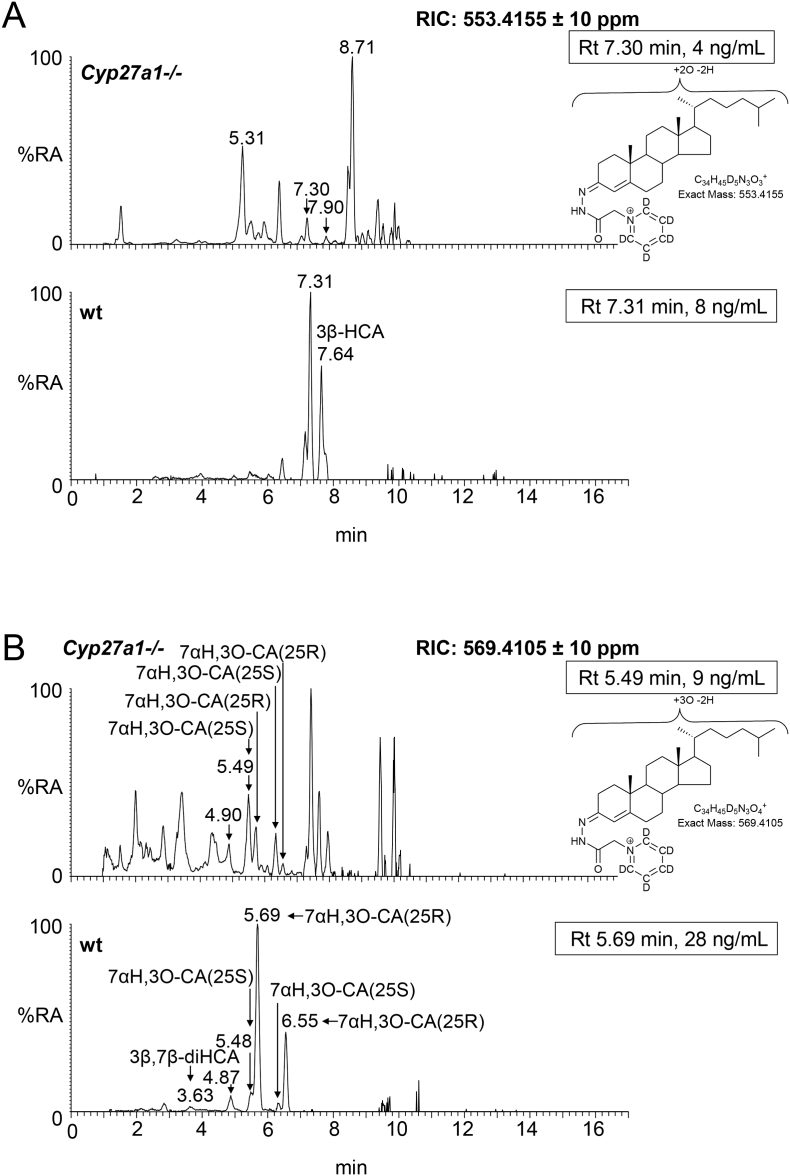
Cholestenoic acids in Cyp27a1−/− and Cyp27a1+/+ (wt) mouse plasma. Each chromatogram is normalised to the most intense peak at 100% RA. Magnification factors are as indicated. The concentration of the indicated analyte (by Rt) is given in the right-hand corner of each chromatogram. Chromatograms from the oxysterol fractions treated with cholesterol oxidase (combination of sterols with a native 3-oxo group and those oxidised by cholesterol oxidase to contain a 3-oxo group) are shown in (A)–(B). The insets show structures of generic GP derivatives. Many cholestenoic acids elute as twin peaks corresponding to syn and anti conformers. (A) 3β-Hydroxychest-5-enoic and 3-oxocholest-4-enoic acids, and dihydroxycholestenones and hydroxycholestenediones. (B) Dihydroxycholestenoic and hydroxyoxocholestenoic acids. (C) Dihydroxyoxocholestenoic acids. Abbreviations: 3β-HCA, 3β-hydroxycholest-5-en-(25R)26-oic; 7αH,3O-CA(25R or S), 7α-hydroxy-3-oxocholest-4-en-(25R or S)26-oic; 3β,7β-diHCA, 3β,7β-dihydroxycholest-5-en-26-oic; and 7α,12α-diH,3O-CA(25R or S), 7α,12α-dihydroxy-3-oxocholest-4-en-(25R or S)26-oic acids. The peaks at 7.30 min and 7.31 min in (A) are annotated to a combination of 3β,22-dihydroxycholest-5-en-24-one and 22-hydroxycholest-4-ene-3,24-dione. The peaks at 4.90 min and 4.87 min in (B) are annotated to 3β,22,25-trihydroxycholest-5-en-24-one.